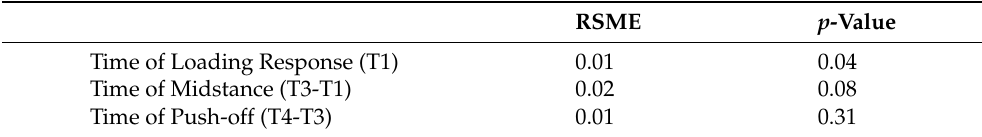
Table A2. Time Variables